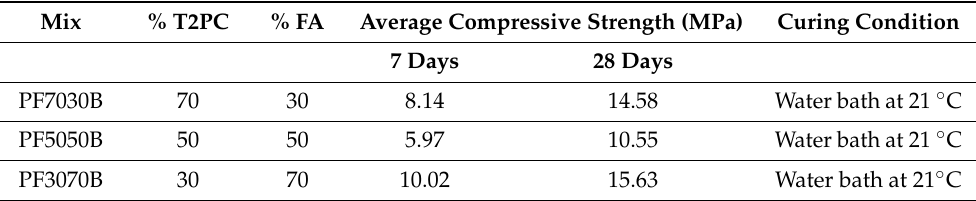
Table 13. Compressive strength of various mixes with AS for the percentages of 30%, 50%, 70% FA.